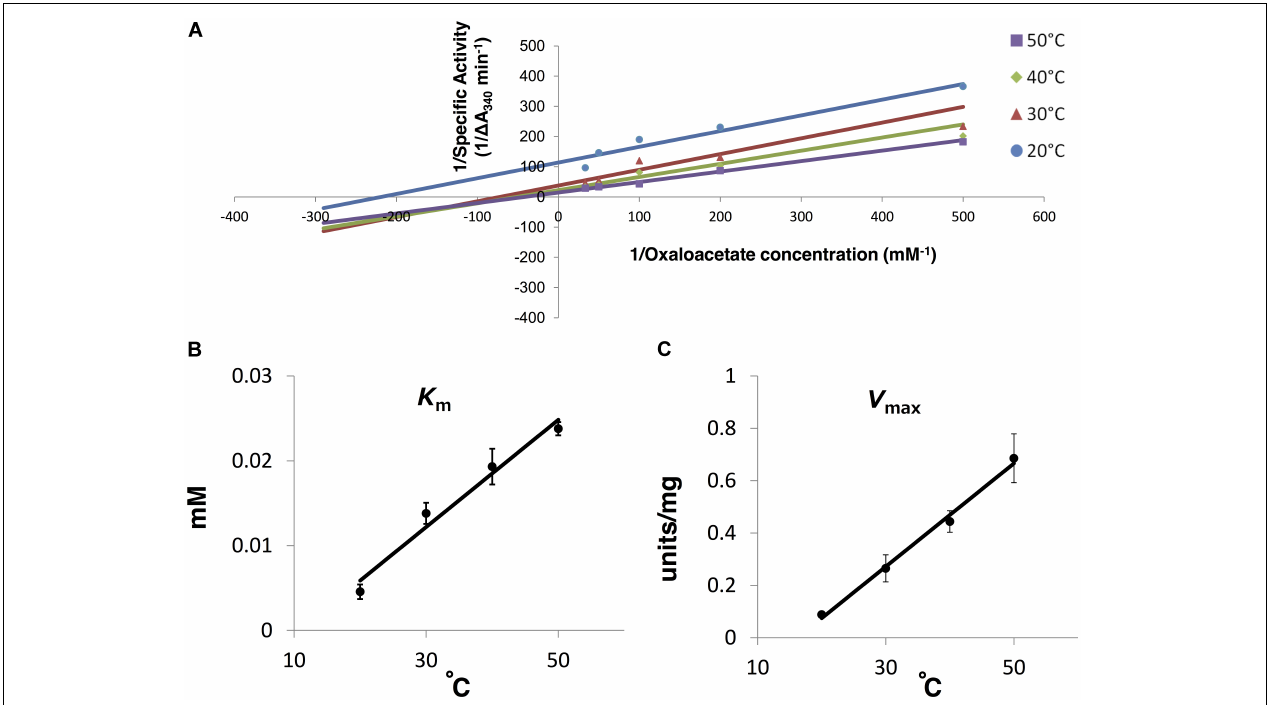
FIGURE 7 | Thermal profiles of Sy MDH in the reductive reaction in vitro . (A) Lineweaver–Burk plot of the Sy MDH activity in the reductive reaction at 20–50 ◦ C. Blue, red, green, and purple lines indicate condition at 20, 30, 40, and 50 ◦ C, respectively. The graph shows the mean of three independent experiments. (B) K m (mean ± SD) values for oxaloacetate were obtained from three independent experiments by varying the temperature (20–50 ◦ C). (C) V max (mean ± SD) (units/mg protein) values for oxaloacetate were obtained from three independent experiments by varying the temperature (20–50 ◦ C).